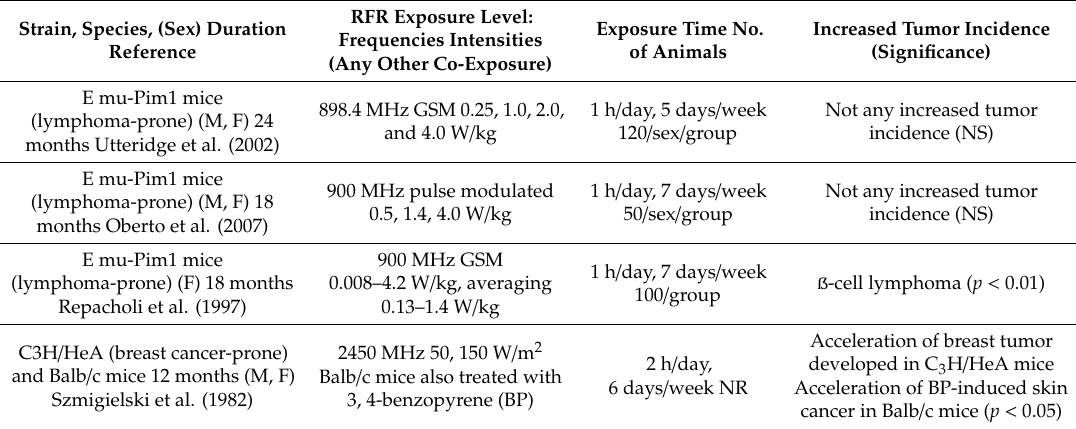
Table 3. Studies of carcinogenicity in other models exposed at least two years to RFR.